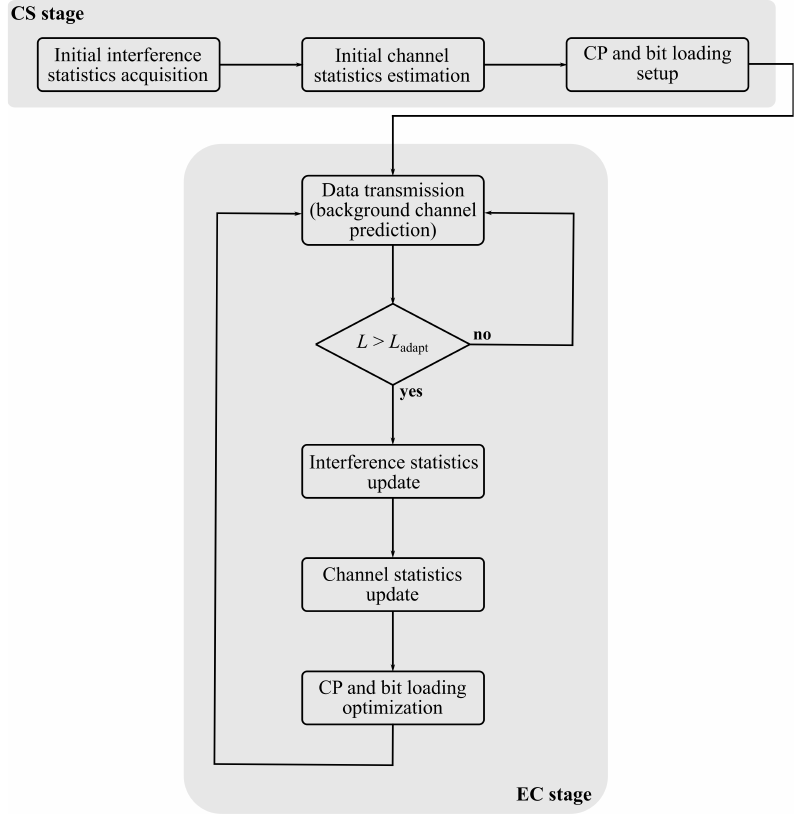
Figure 2. Protocol summary for CS and EC